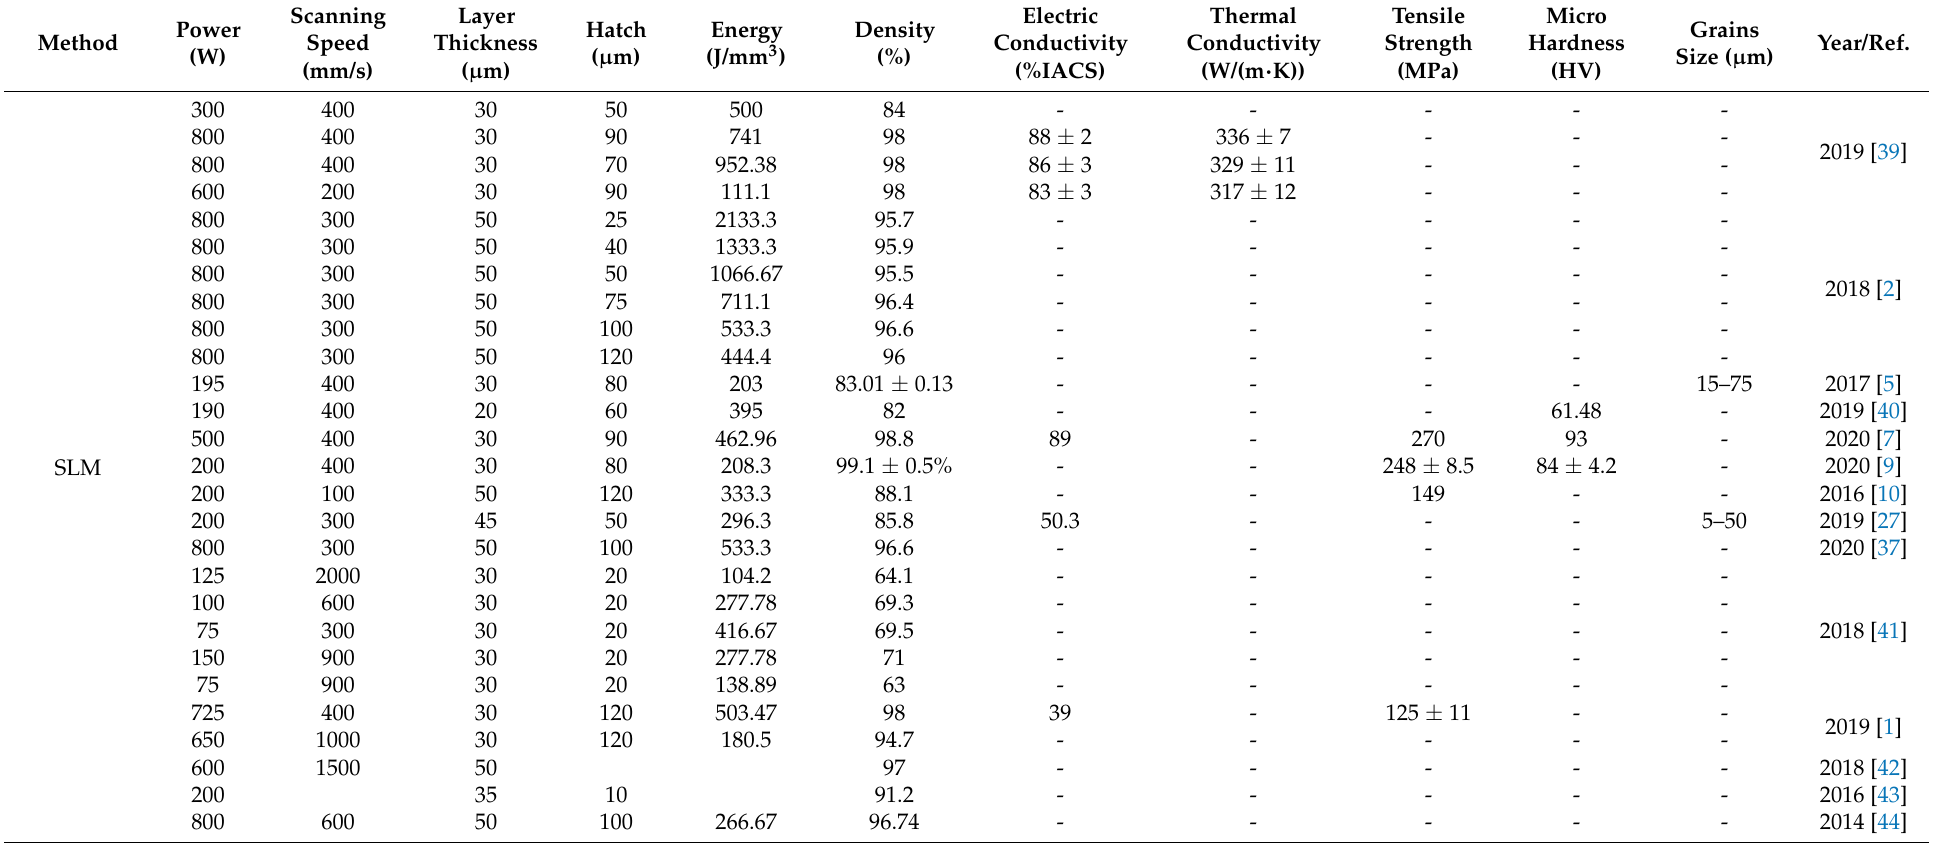
Table 1. Study on additive manufacturing of pure copper SLM, SEBM and